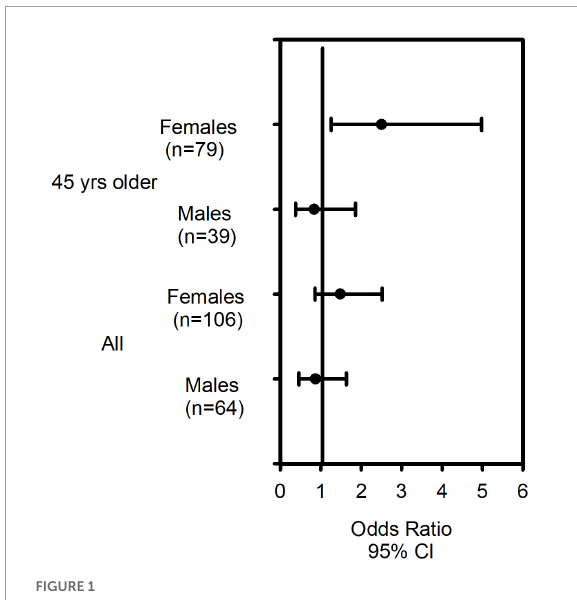
FIGURE2 The CRTh2 rs533116 G > A polymorphism is associated with ICS usage. Asthmatics were genotyped and assessed for the likelihood of being prescribed high dose ICS ( > 1600 µ g/day, budesonide equivalent), an indicator of asthma severity. (A) Older females (AA = 11, GG/GA = 68) and (B) older males (AA = 8, GG/GA = 31) were assessed for the influence of the A allele on this outcome. Statistical differences determined Mann-Whitney U